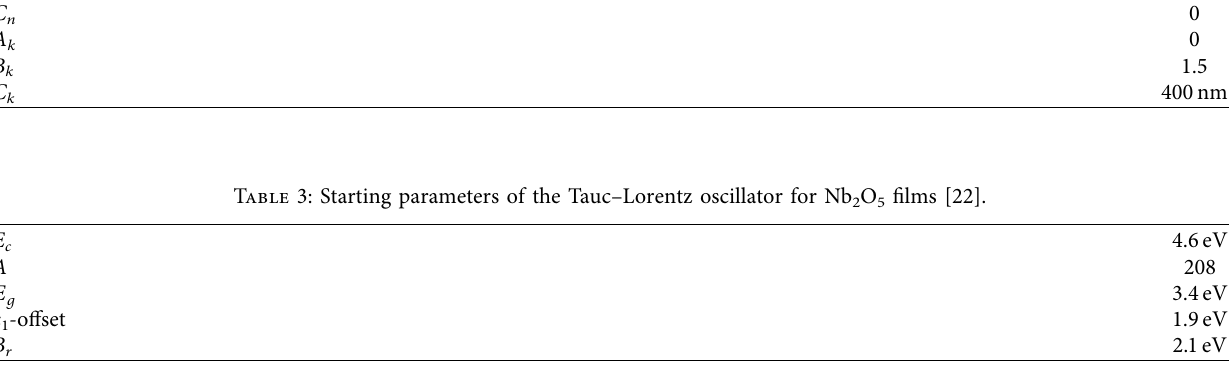
Table 4: Design targets for the bandpass flter [22].